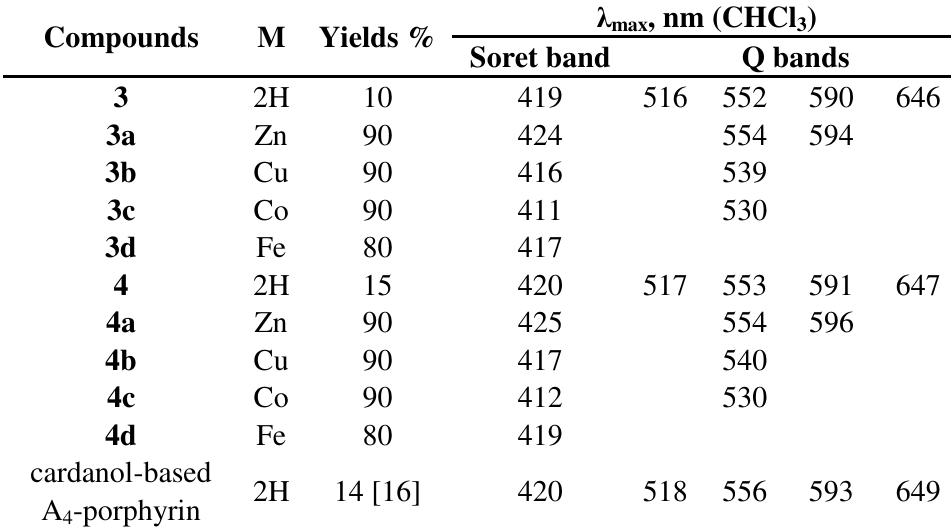
Table 1. Yields and UV-Vis absorption bands of 3 , 4 and their metalloporphyrins 3a–3e , 4a–4e